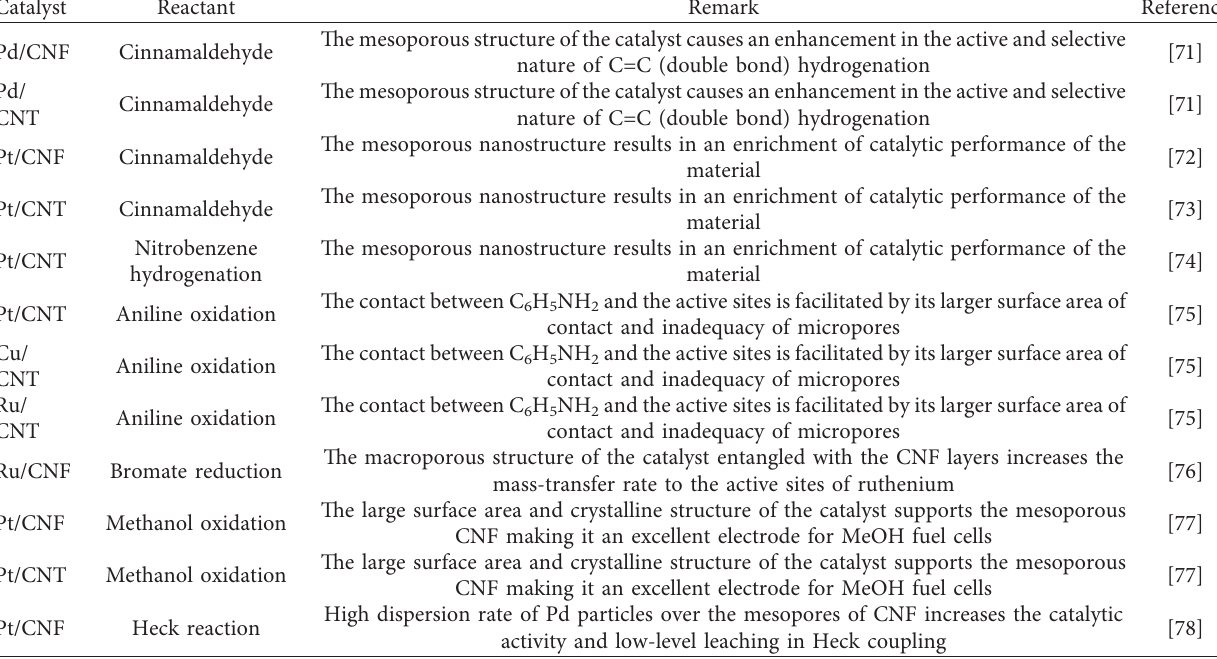
Table 5: Liquid-phase reactions using catalysts of CNTs/CNFs with a metal